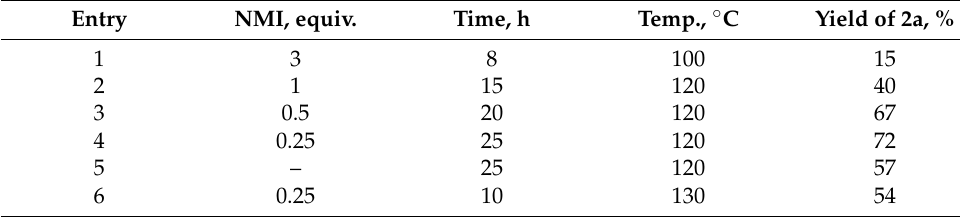
Table 1. Reaction condition optimization for the enamination of 1a .